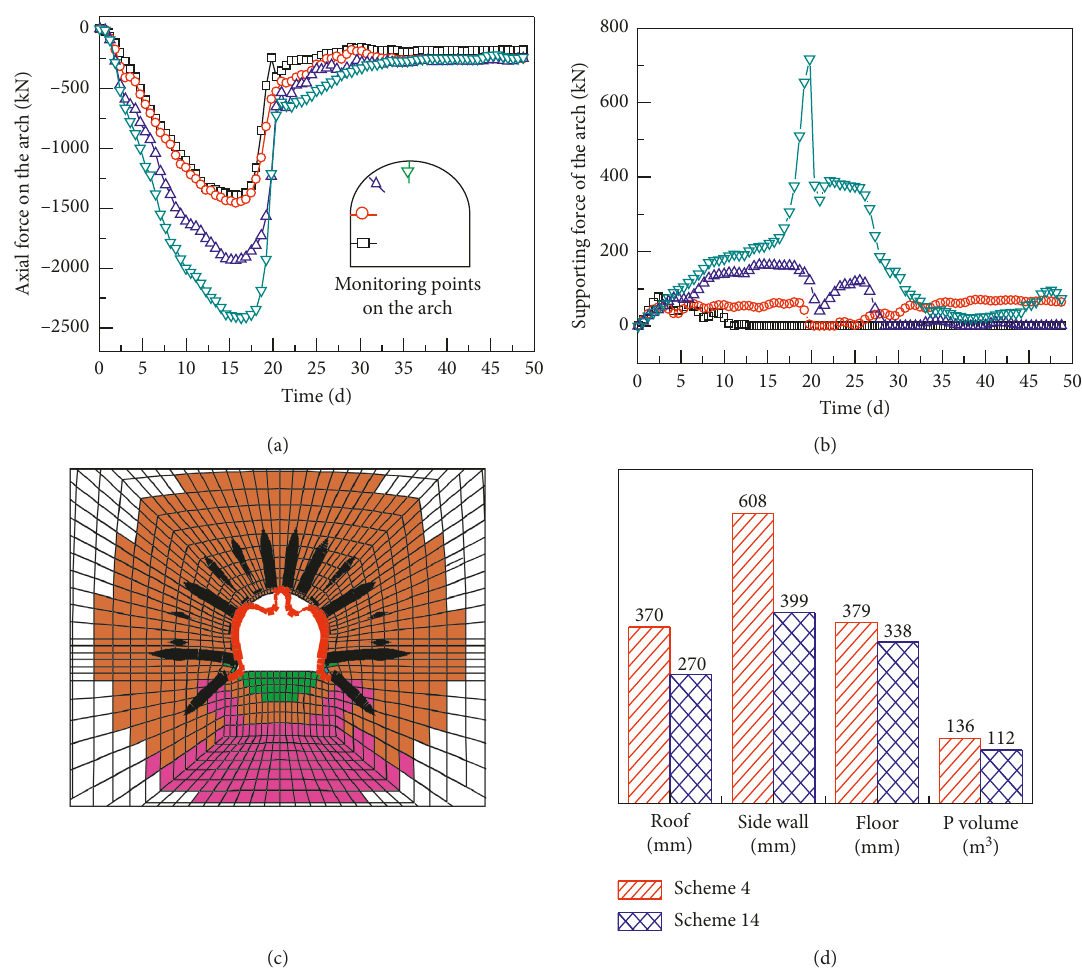
Figure 14: Main results of Scheme 14. (a) Arch axial force curves. (b) arch supporting forces. (c) Surrounding rock plastic zones and supporting structure inner force diagrams. (d) Comparative columns of the surrounding rock control effect of Scheme 14 and Scheme